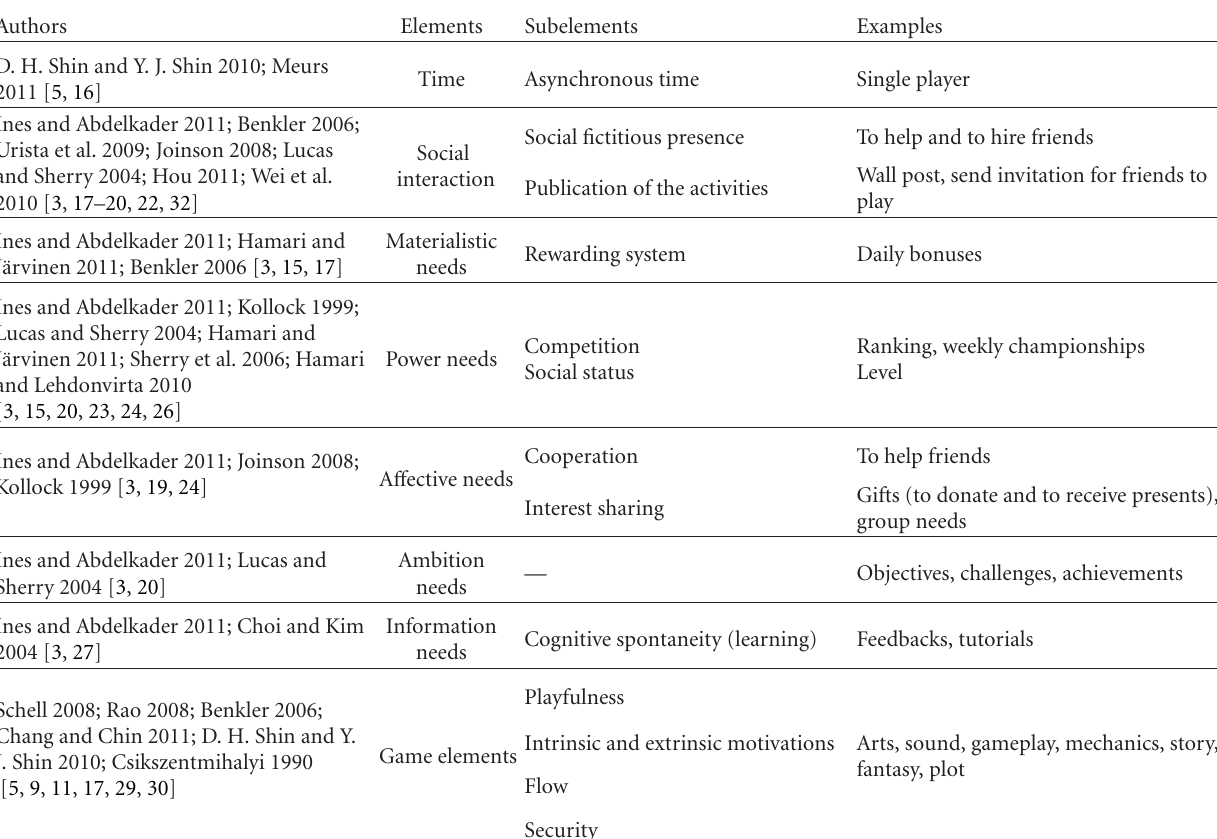
Table 1: Main motivational elements of the social games.